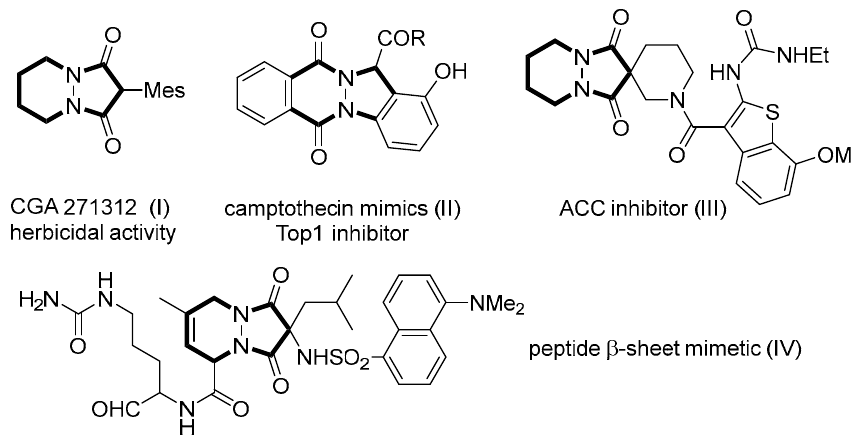
Figure 1. Representatives of bioactive pyridazine-fused heterocycles (I–IV).